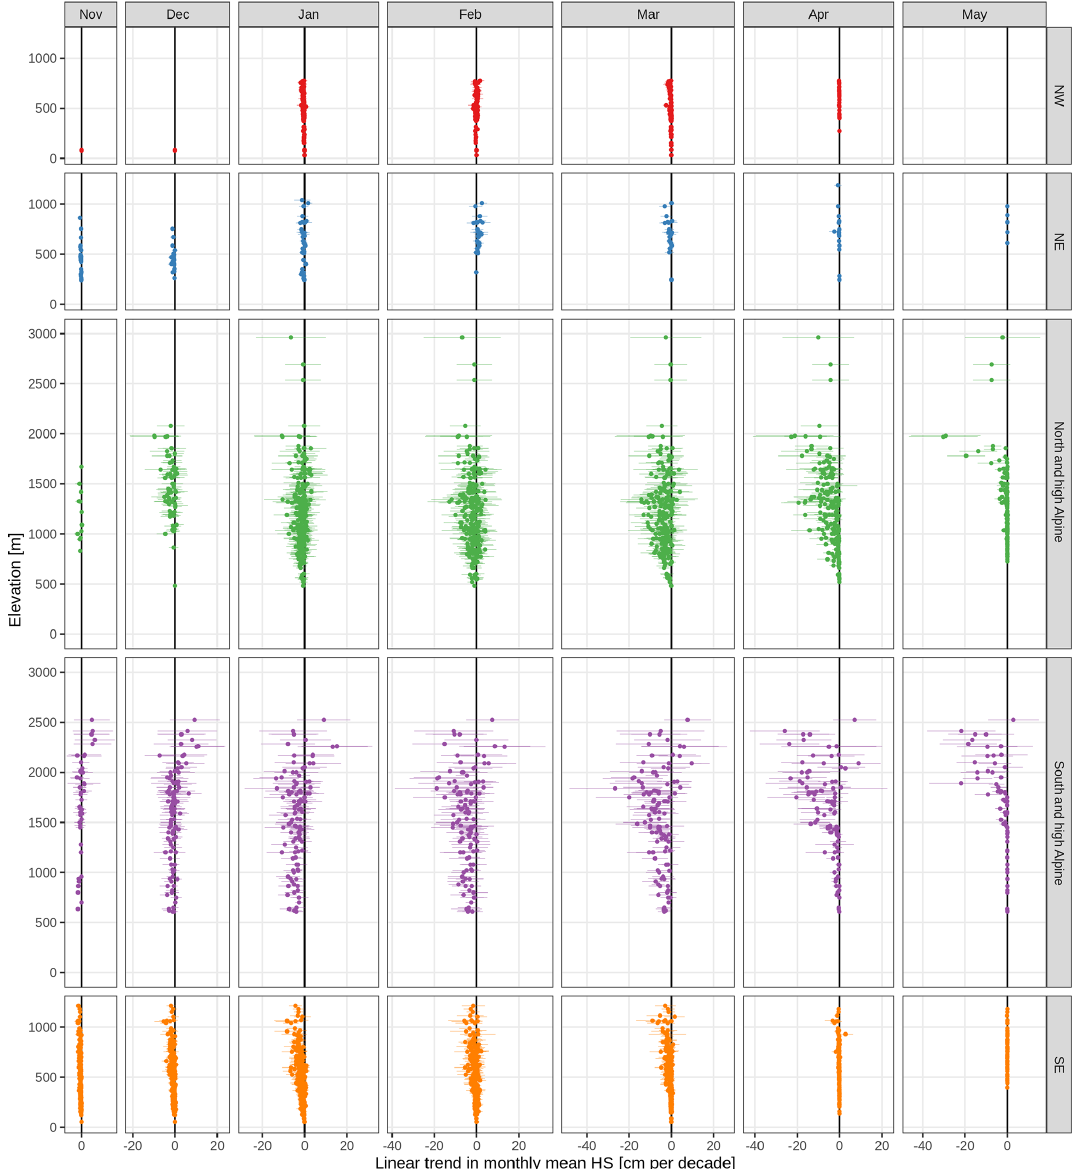
Figure 7. Long-term (1971 to 2019) linear trends in mean monthly snow depth (HS). Trends are shown separately by month (columns) and region (rows). Each point is one station. The points indicate the trend and the lines the associated 95% confidence